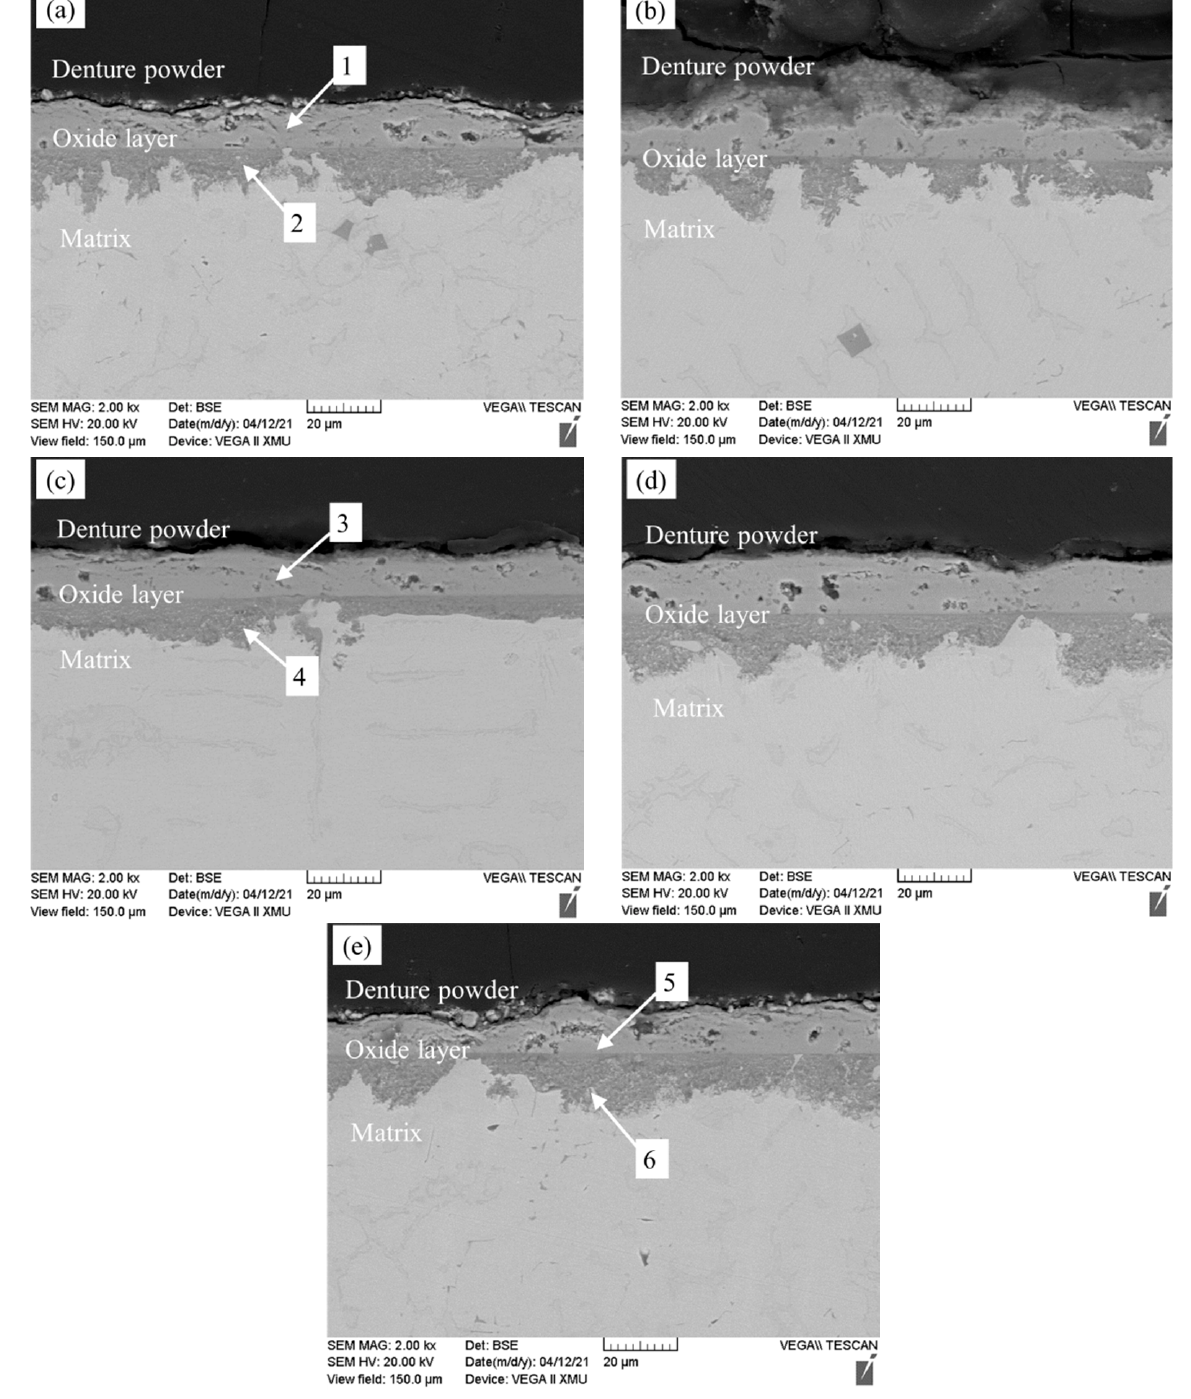
Figure 12. Longitudinal cross-sections of Fe-25Mn-9Al-8Ni-1C-xTi alloy oxidized for 200 h. ( a ) 0 wt.% Ti; ( b ) 0.1 wt.% Ti; ( c ) 0.2 wt.% Ti; ( d ) 0.3 wt.% Ti; ( e ) 0.4 wt.% Ti. Table 4. The average thickness of oxidation layer of alloy with 600 °C insulation for 200 h.